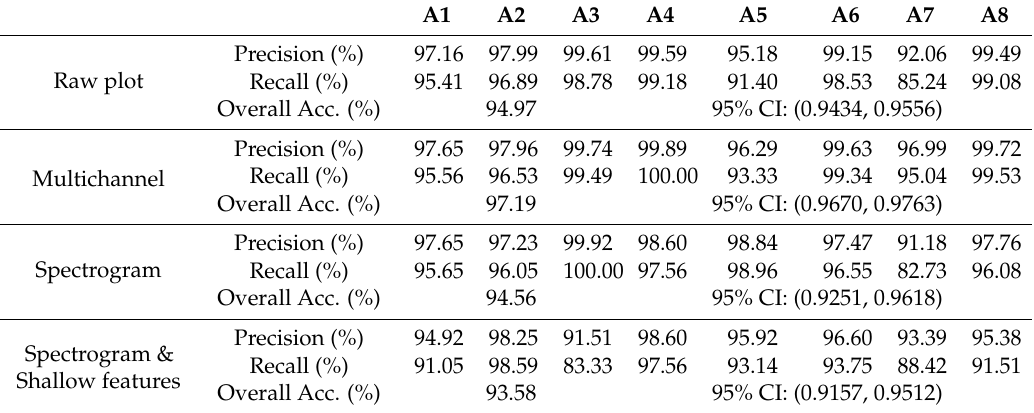
Table 4. Performance of each model based on a segment length of 512 (10.24 s). A1: climbing